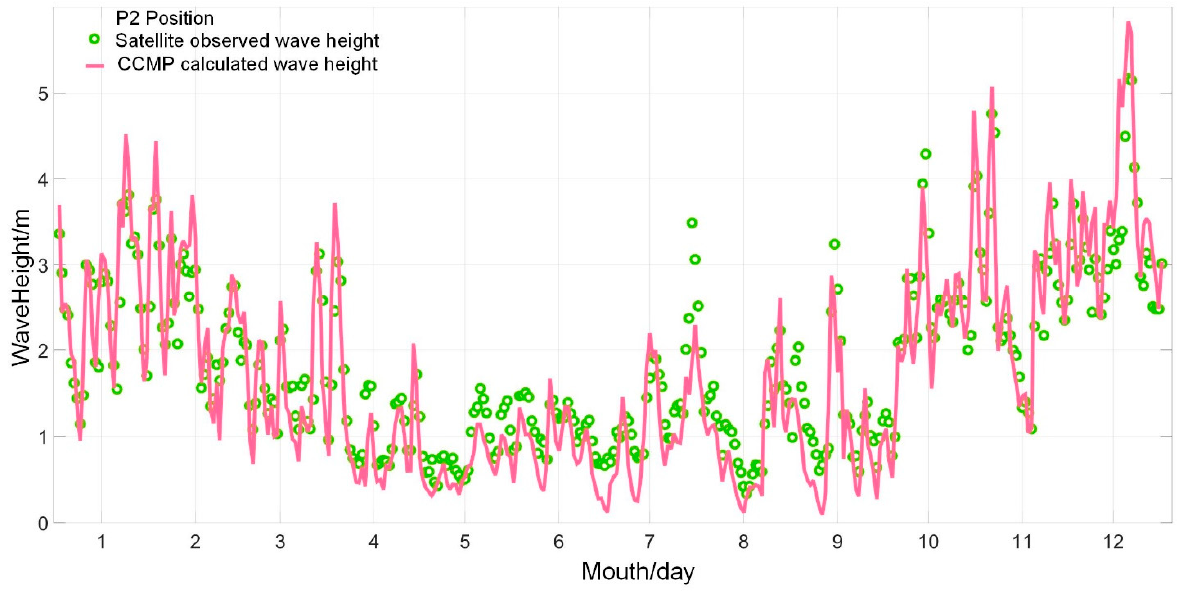
Figure 3. Observed and calculated wave height variation trend at the P2 position. The pink line represents the simulated wave height of the CCMP wind field, and the green dotted line represents the observed data of the altimeter.